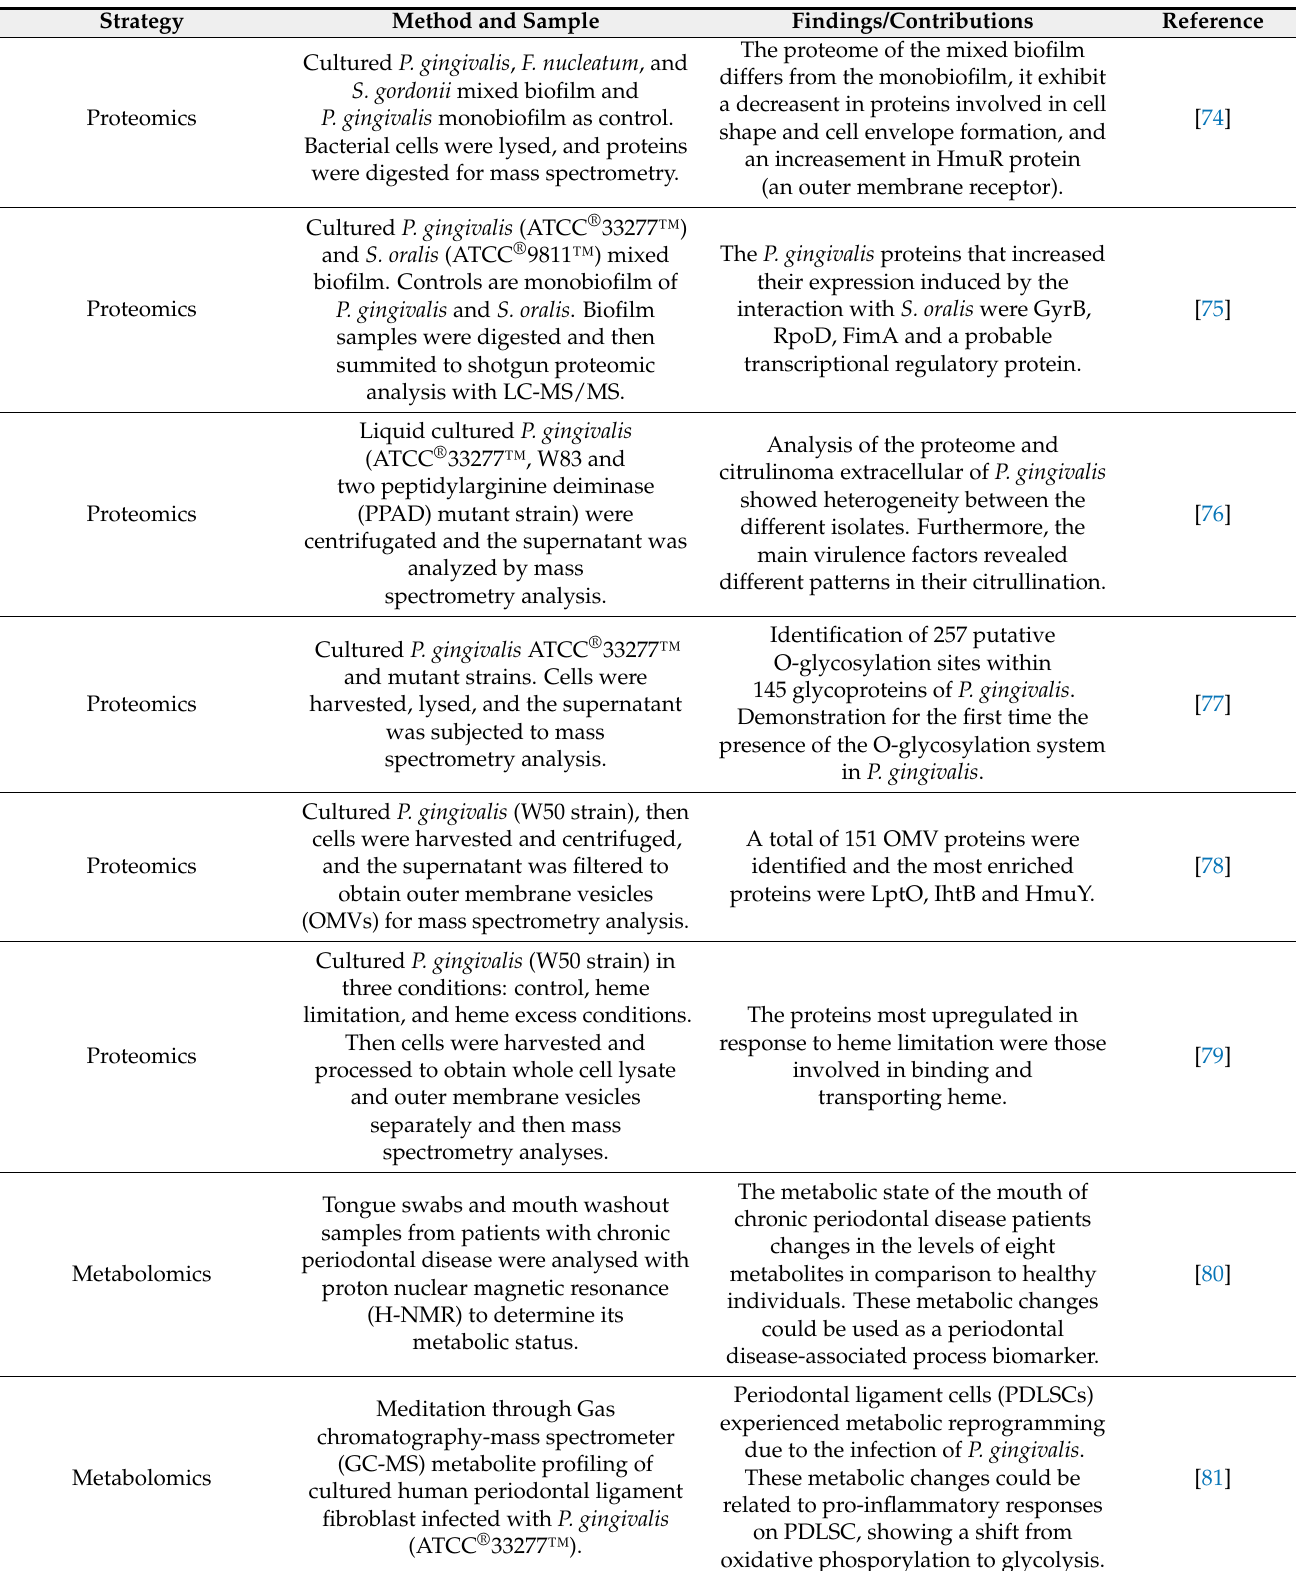
Table 3. Summary of metabolomics and proteomics research studies associated to this